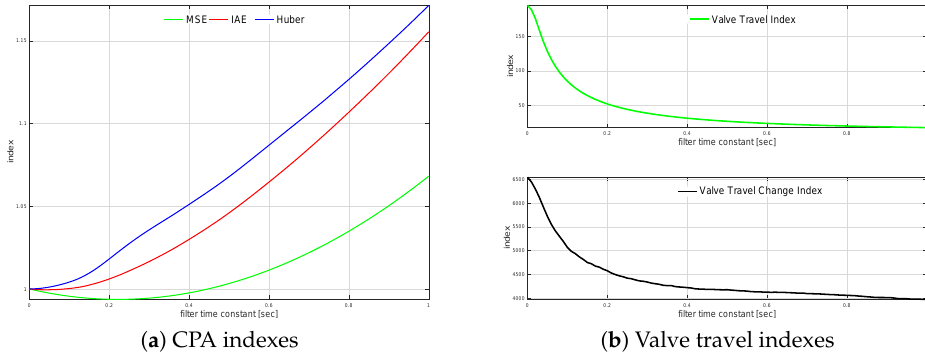
Figure 3. Process variable filtering relationships for G 1 ( s ) .